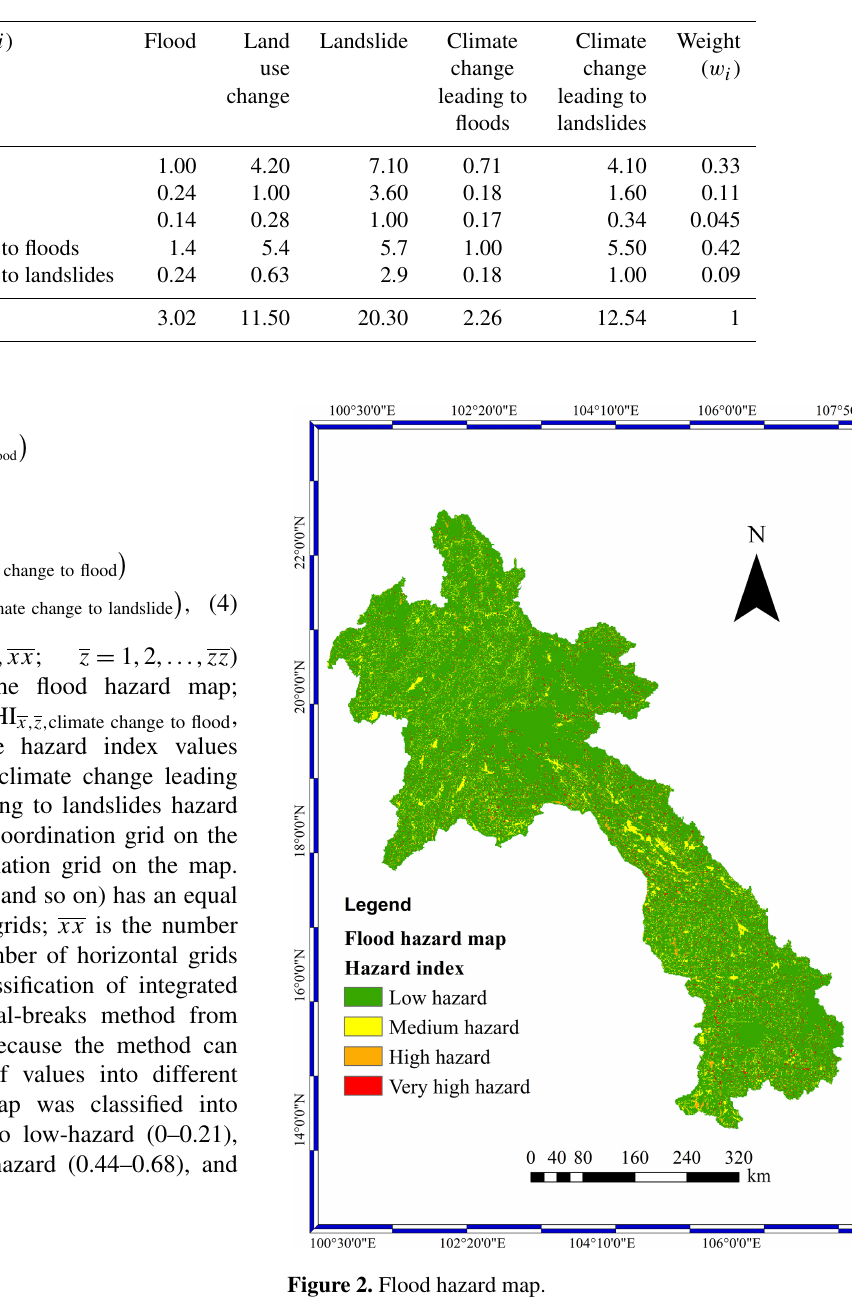
Figure 2. Flood hazard